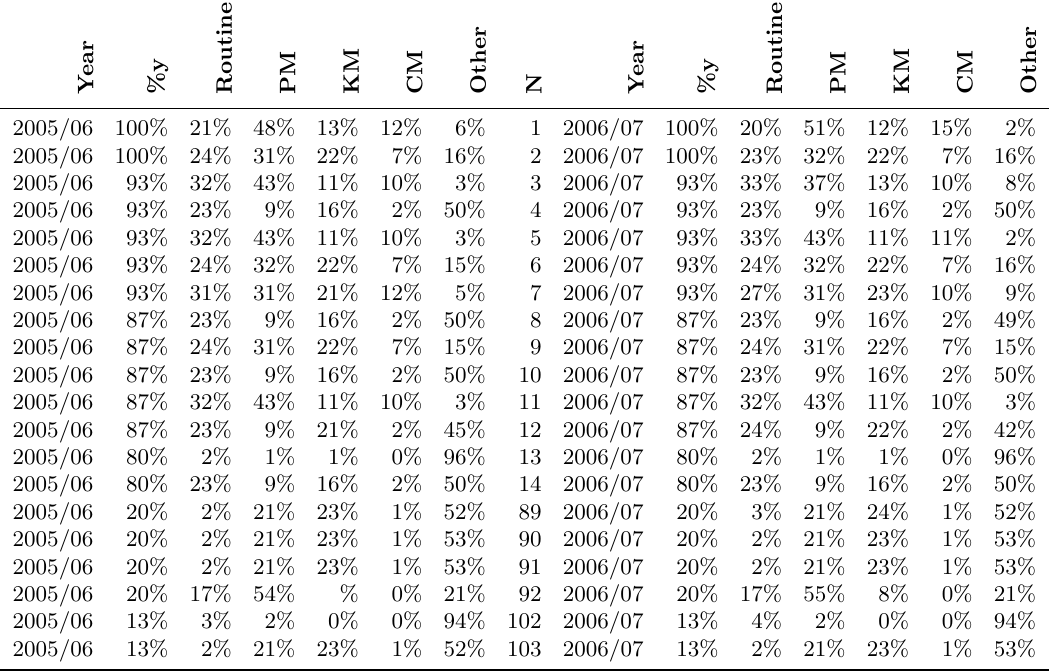
Extract of the input-output data set used to fit the resource allocation model. N = Number of Samples; KM = Knowledge Management; CM = Change Management; PM = Project Management; y = output